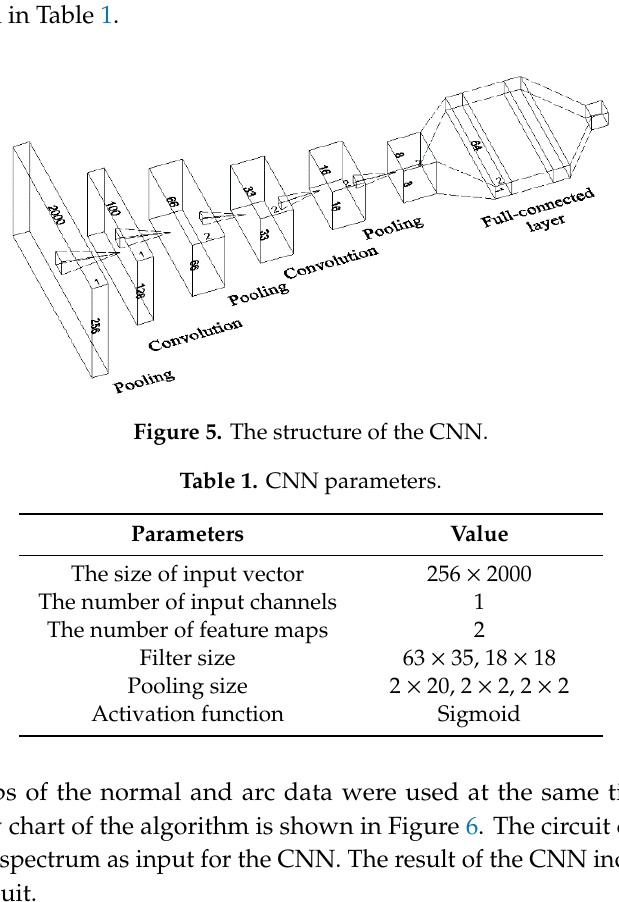
Figure 4. Time–frequency spectrum of the normal current based on db4.